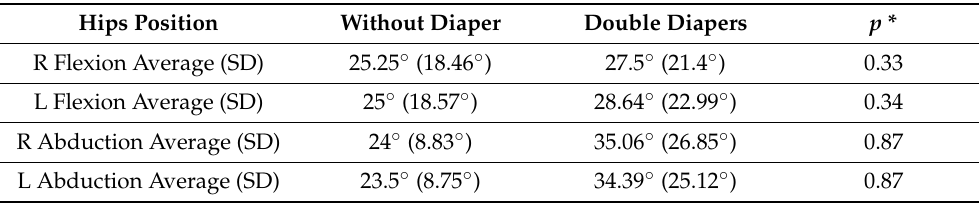
Table 1. Flexion and abduction degrees measurement of the right (R) and left (L) hips with standard deviation (SD) without diaper and with double diapers.